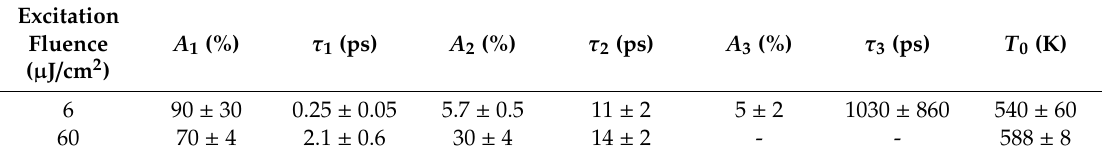
(cid:80) n ) and A = 100 a i (cid:80) a i exp ( − t / τ i i i = 1 (cid:3415) (cid:3439) (cid:2924) (cid:3036)(cid:2880)(cid:2869) and (cid:1827) (cid:3036) = j a j (cid:3036)